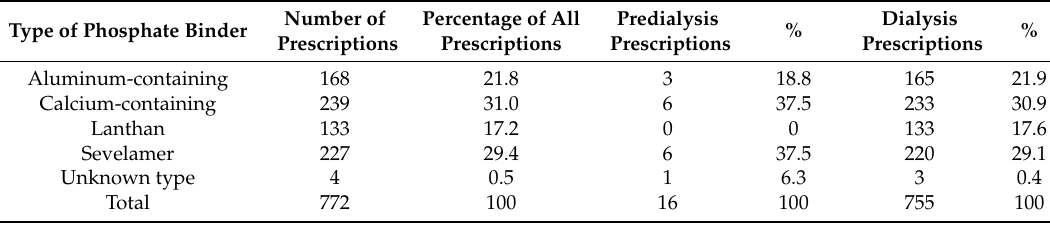
Table 11. Summary of phosphate binders at study start.